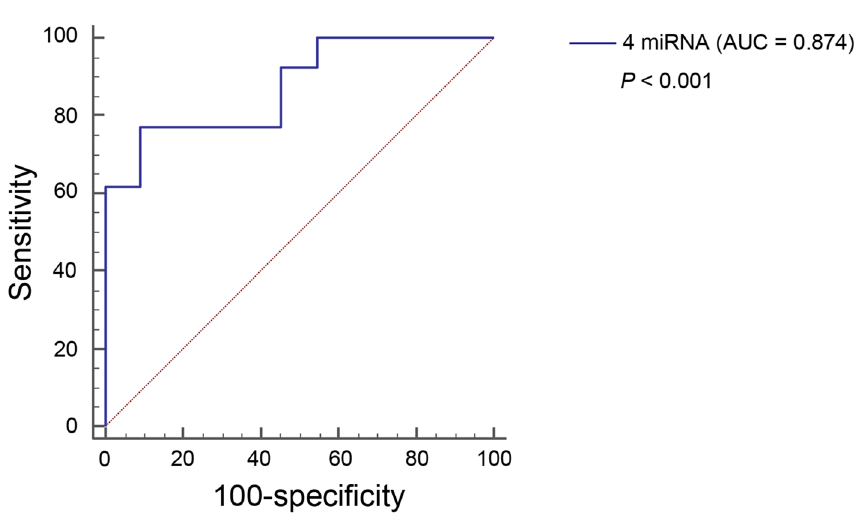
Figure 4. Diagnostic accuracy of miRNA combination in validation cohort. Receiver operating characteristic (ROC) curve for diagnostic accuracy for NASH in validation cohort. The blue line represents the ROC curve for the combination of four miRNAs (miR-21-5p, miR-151a-3p, miR-192-5p, and miR-4449) with ∆∆Ct